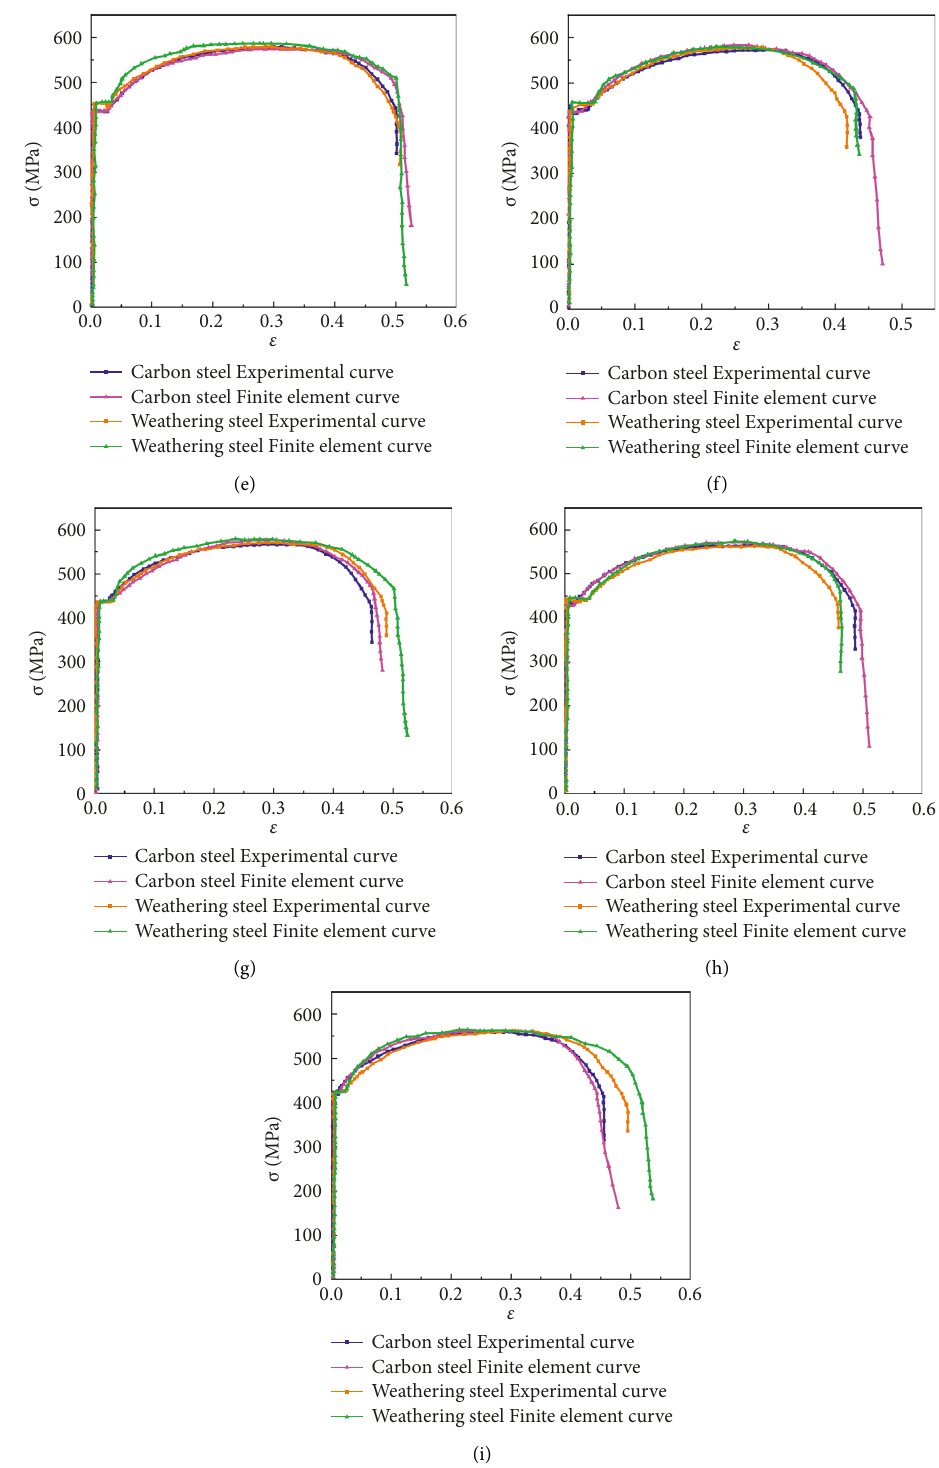
Figure 18: Stress-strain curves of corrosive carbon steel and weathering steel. (a) 0h. (b) 1h. (c) 2 h. (d) 4h. (e) 8h. (f) 12 h. (g) 24 h. (h) 48h. (i) 72